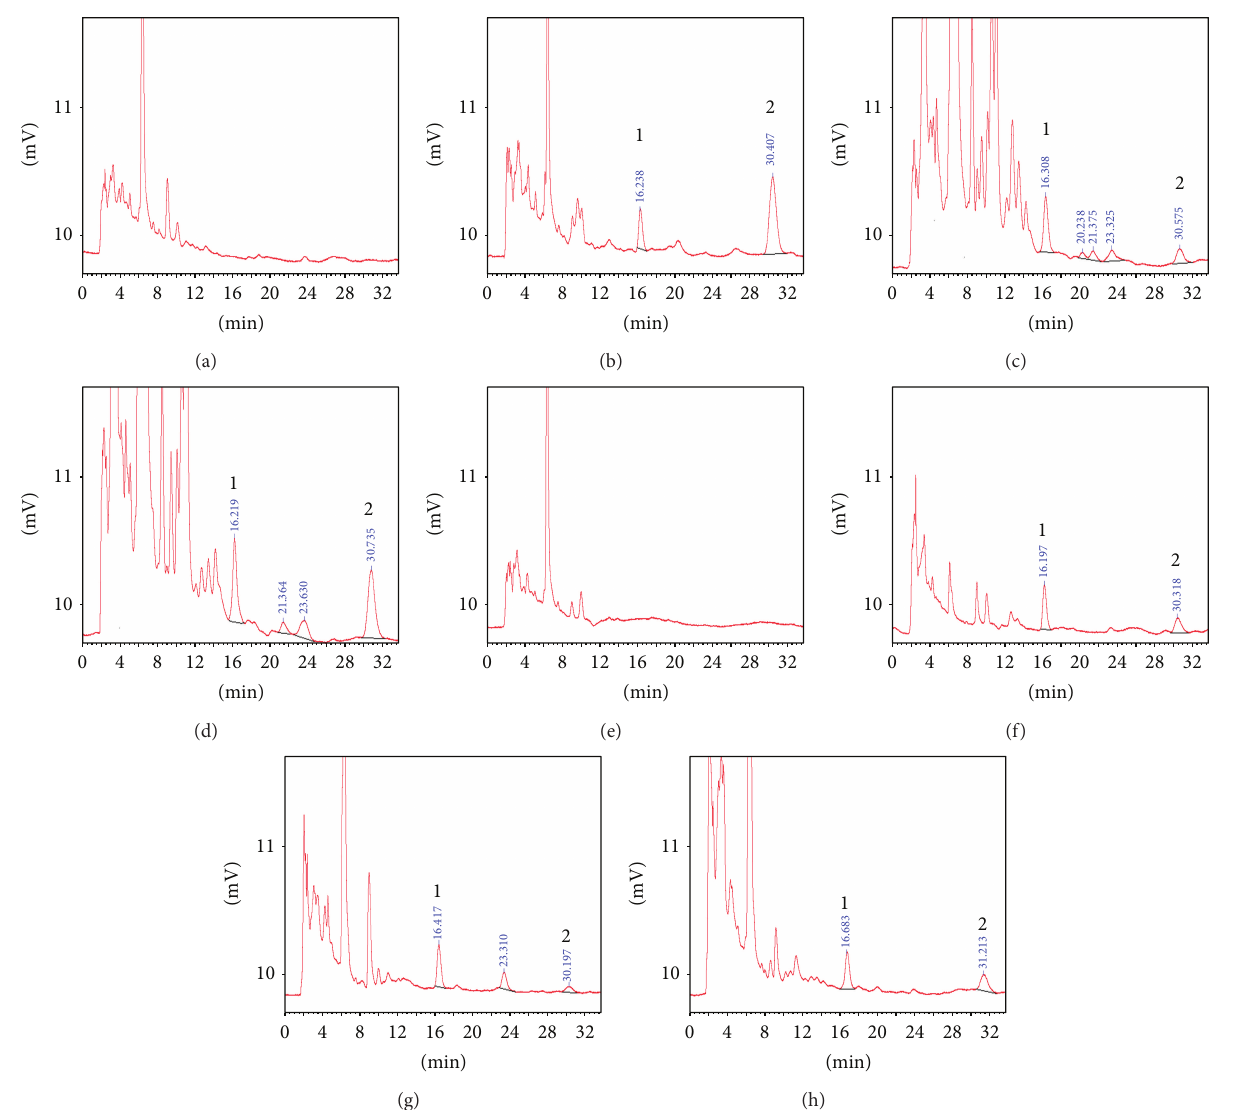
Figure 2: Chromatograms of blank plasma (a); blank plasma spiked with (4 E ,6 E ,12 E )-tetradecatriene-8,10-diyne-1,3-diyl diacetate 20 𝜇 L (0.143 𝜇 g ⋅ mL −1 ) and IS 20 𝜇 L (0.00504 mg ⋅ mL −1 ) (b); rat plasma sample (4h) after oral administration of raw Atractylodis Rhizoma 40 g ⋅ kg −1 (c); rat plasma sample (4h) after oral administration of processed Atractylodis Rhizoma 40g ⋅ kg −1 (d); Chromatograms of blank tissue homogenate (e); blank tissue homogenate with (4 E ,6 E ,12 E )-tetradecatriene-8,10-diyne-1,3-diyl diacetate 20 𝜇 L (0.286 𝜇 g ⋅ mL −1 ) and IS 20 𝜇 L (0.00504 mg ⋅ mL −1 ) (f); spleen sample (2h) after oral administration of raw Atractylodis Rhizoma 40 g ⋅ kg −1 (g); spleen sample (2h) after oral administration of processed Atractylodis Rhizoma 40 g ⋅ kg −1